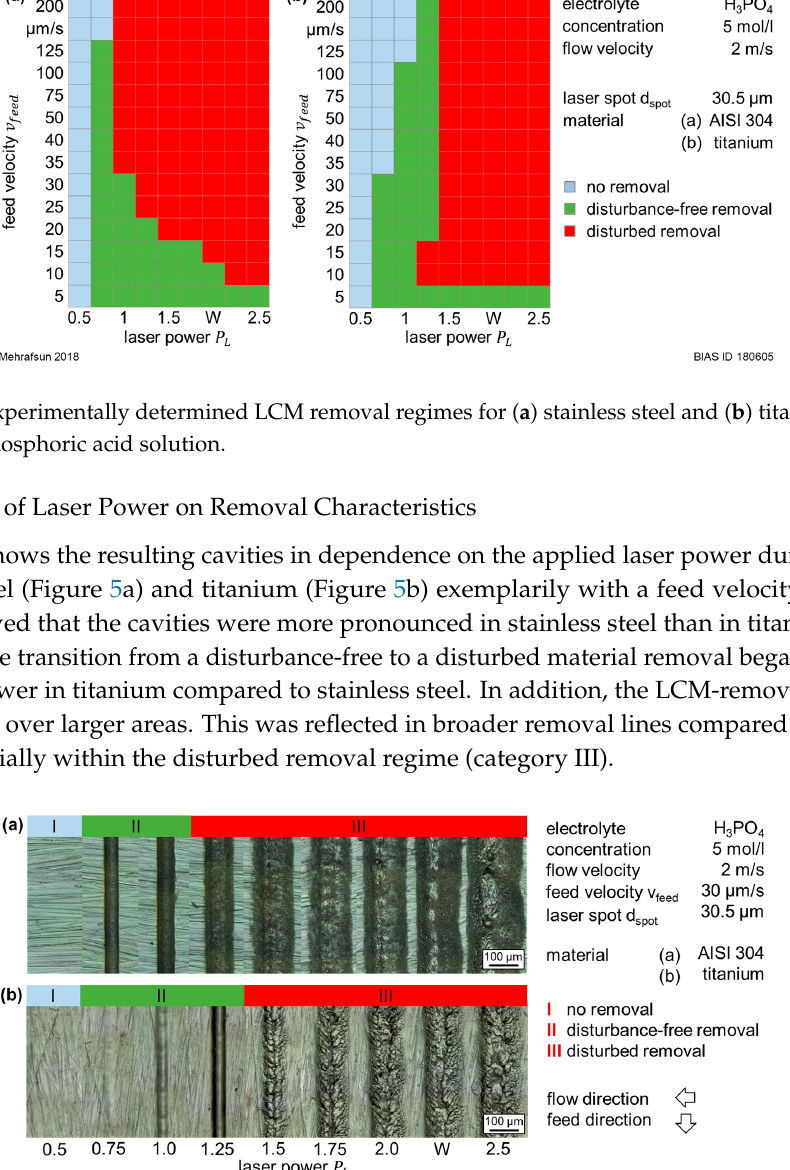
Figure 5. Confocal micrographs of the resulting LCM cavities in ( a ) stainless steel and ( b ) titanium at a feed velocity v feed of 30 μ m/s in dependence of the applied laser power.